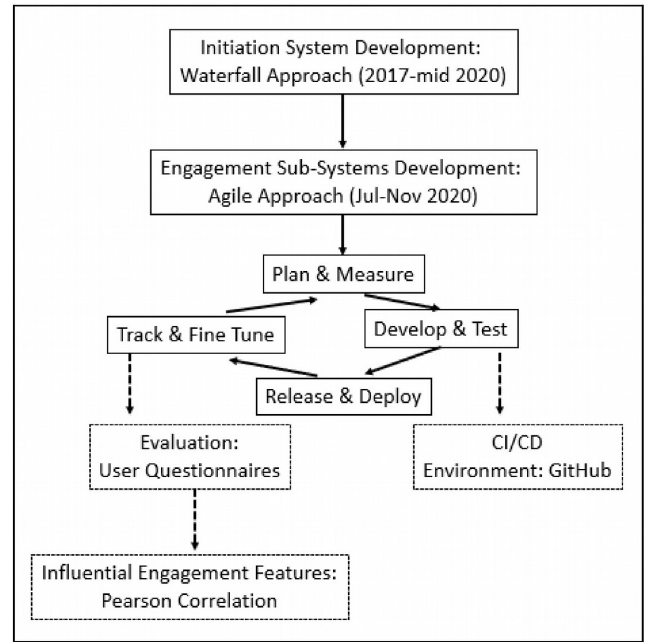
Figure 1. The overall methodology during the development of engagement